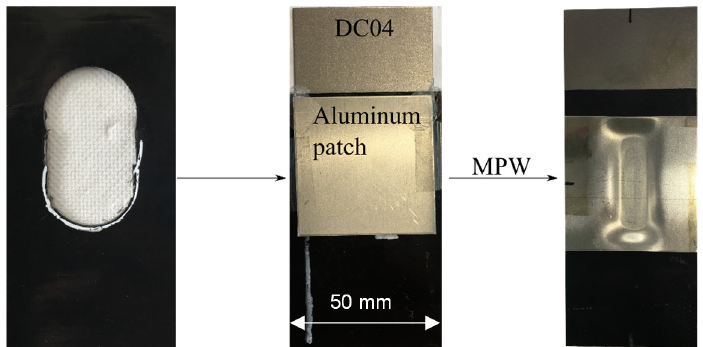
Figure 9. Metallic patch configuration setup: hole in composite, patch over the hole and after welding.